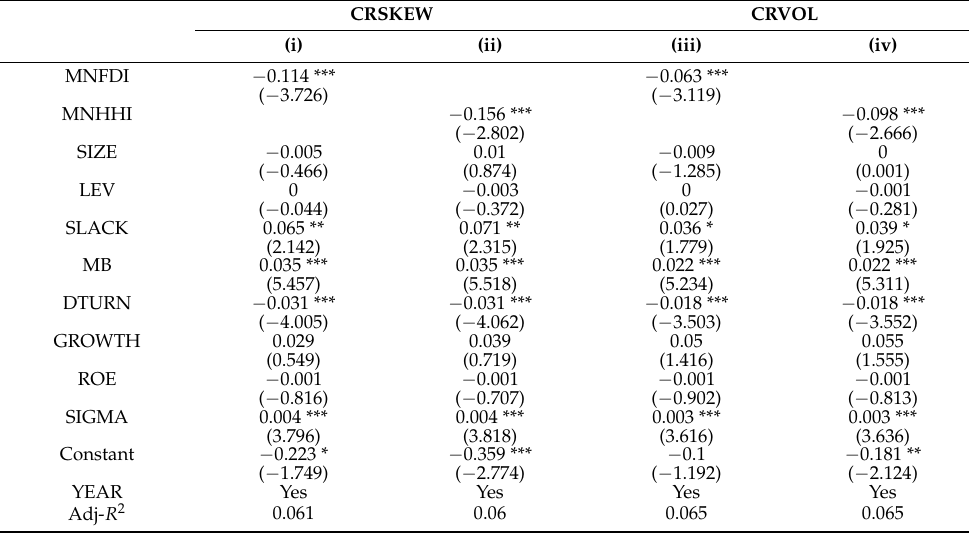
Table 5. Panel Data Regression of Crash Risk on Multinationality.